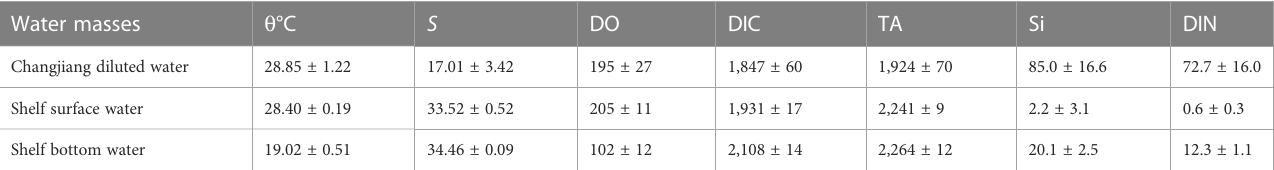
TABLE 1 End-member characteristics of three water masses based on measurements obtained during the cruise. Water masses